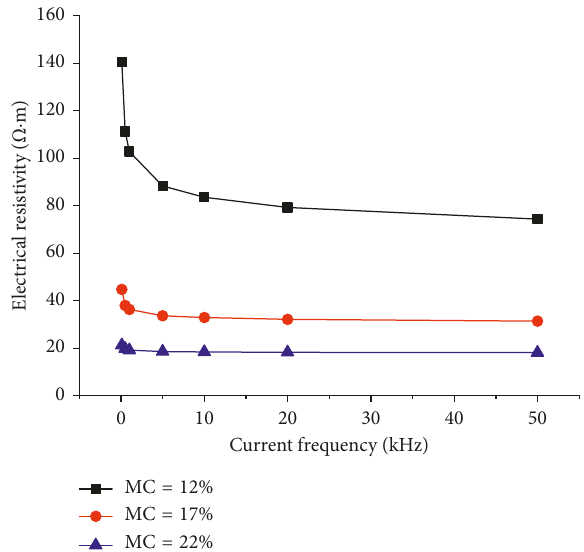
Figure 4: Variations of electrical resistivity with different current